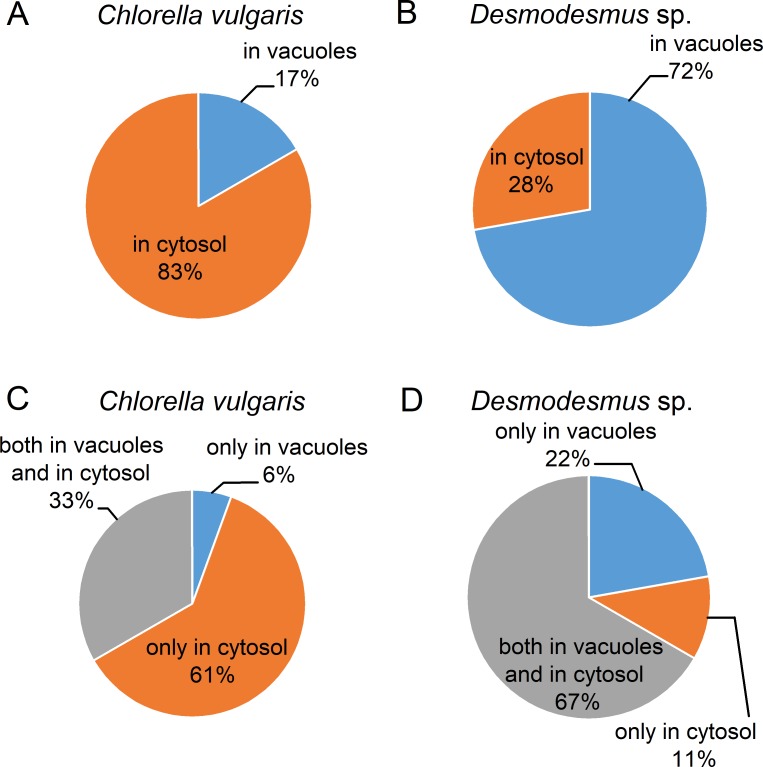
Localization of main P reserves and total P reserves in the studied microalgae.The results are represented for cells sampled from the P-sufficient stationary phase cultures. (A) and (B) Main P reserves in Chlorella vulgaris IPPAS C-1 and Desmodesmus sp. IPPAS S-2014, respectively. (C) and (D) Total P reserves in Chlorella vulgaris IPPAS C-1 and Desmodesmus sp. IPPAS S-2014, respectively. Percentages of cell sections containing the P reserves of the total number of studied cell sections are shown. In (C) and (D) the inclusions localized in chloroplast, nucleus and the inclusions with undetermined localization were not taken into account.